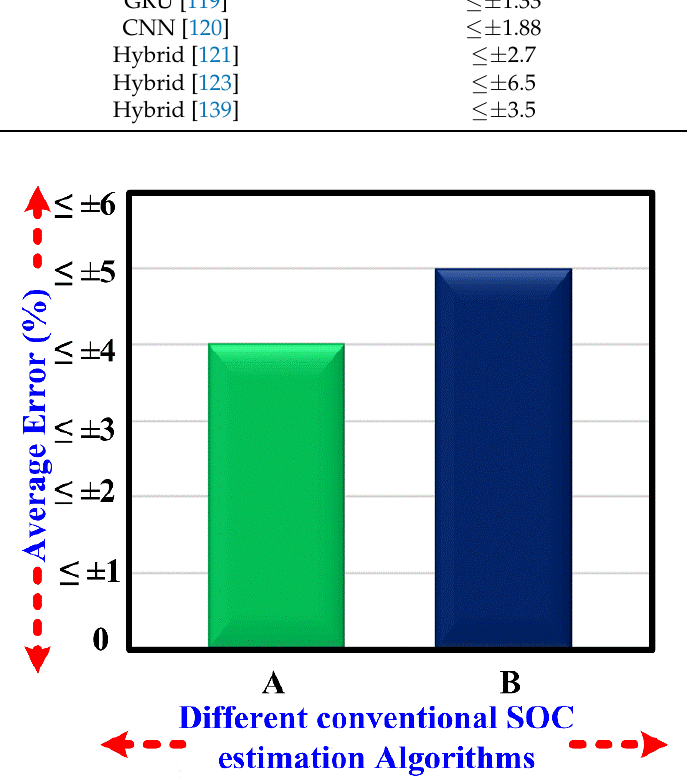
Figure 10. Comparison between the different conventional SOC estimation methods. “A” is referred to as [59], and “B” is referred to as [135].